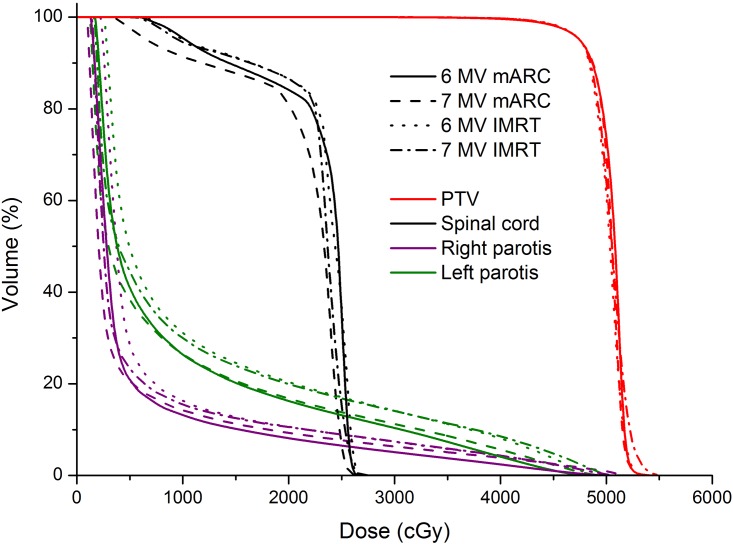
Example DVH (same patient as in Fig 2).